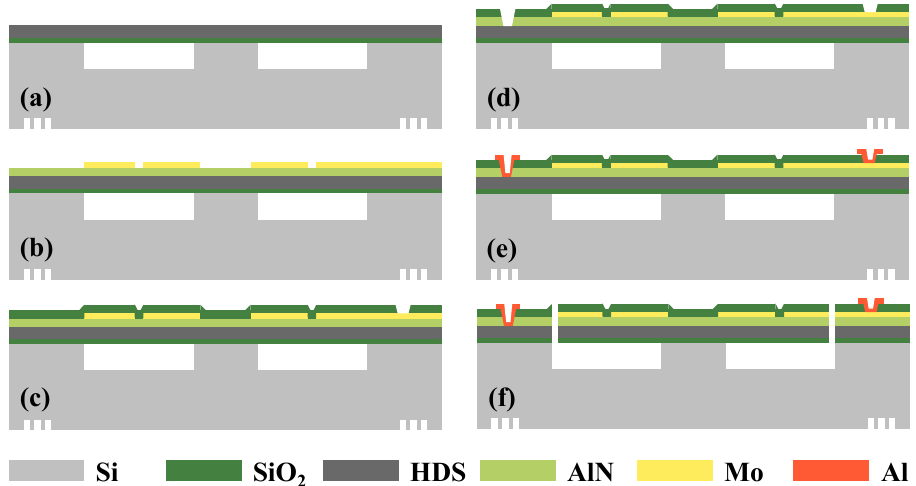
Figure 3. Schematic illustrations of the proposed piezoelectric MEMS accelerometer fabrication flow.